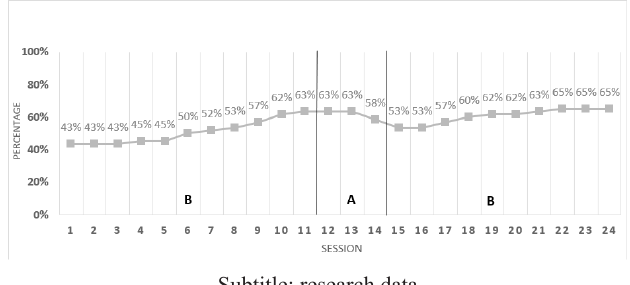
Figure 1. Graph regarding the evolution of the second score of the participant achieved in IAADE.